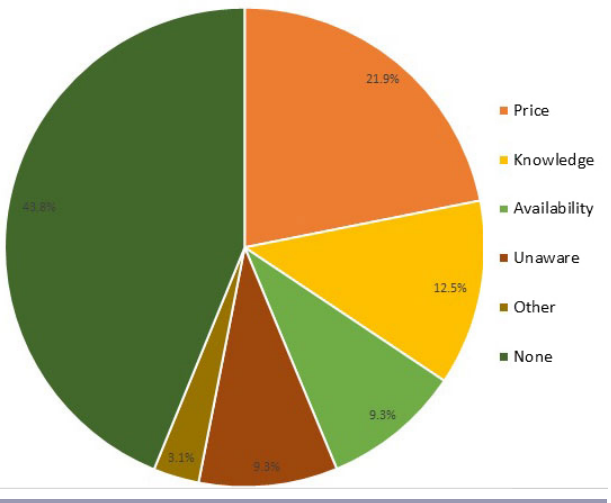
Fig. 5 . Barriers to sourcing sustainable products identified by non-Ocean Wise